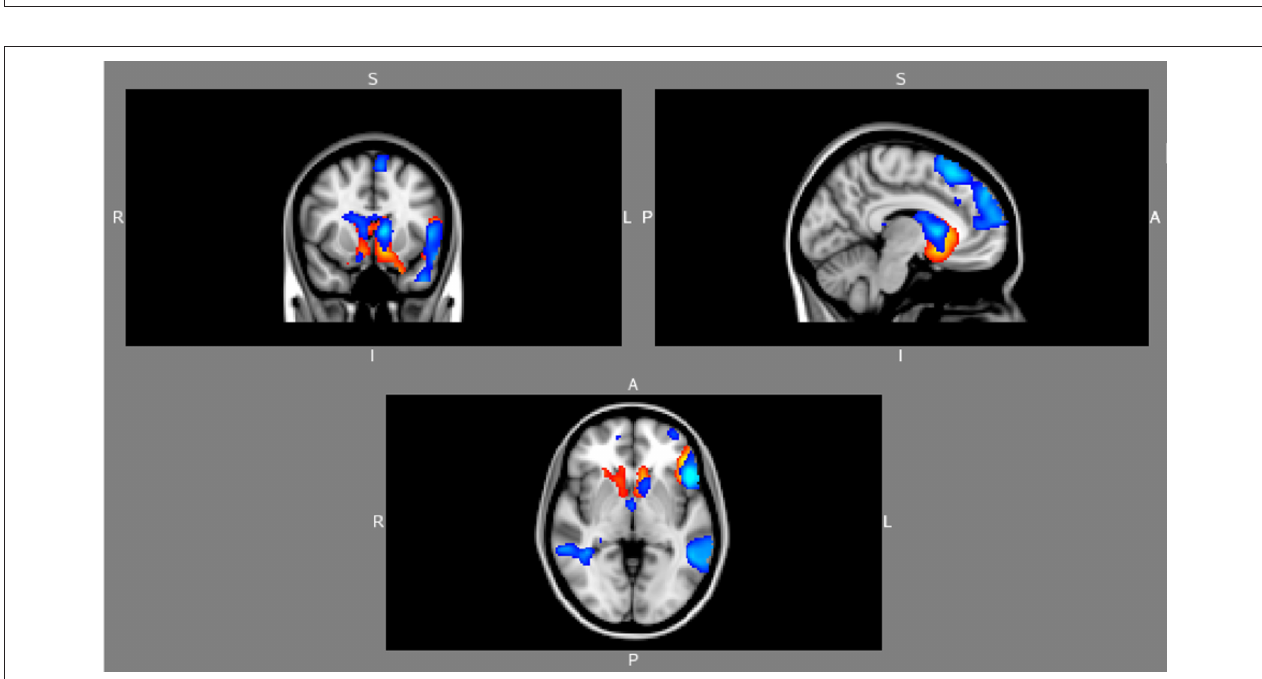
FIguRe 2 | Baseline RMeT minus gender Attribution: Predominant ventral activations in unmedicated depressed subjects at baseline (red) compared to superior frontal and temporal activations in healthy matched controls